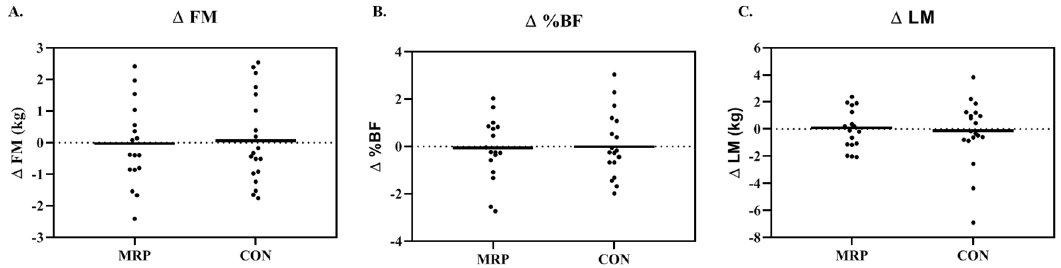
Figure 2. Individual responses for change in ( A ) fat mass ( ∆ FM); ( B ) percent fat ( ∆ %BF); and ( C ) lean